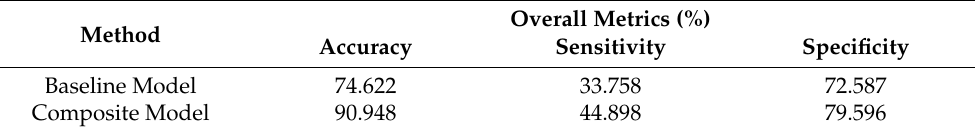
Table 12. Overall performance metrics for baseline model and composite